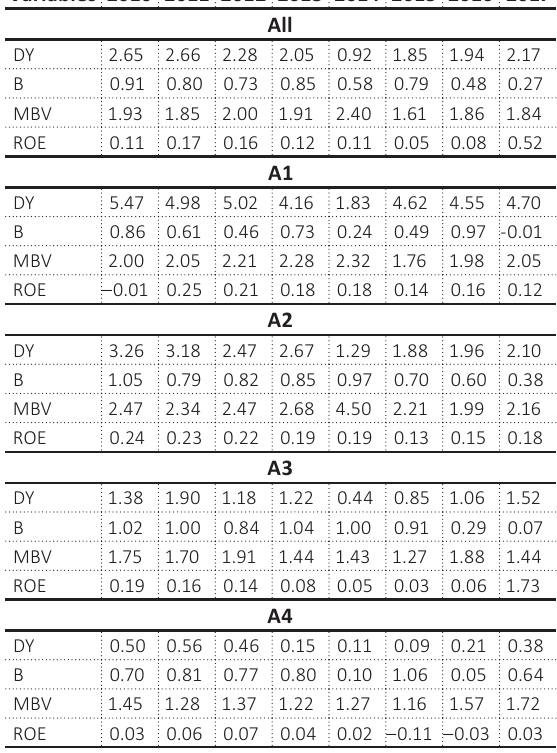
Table 1. Mean of